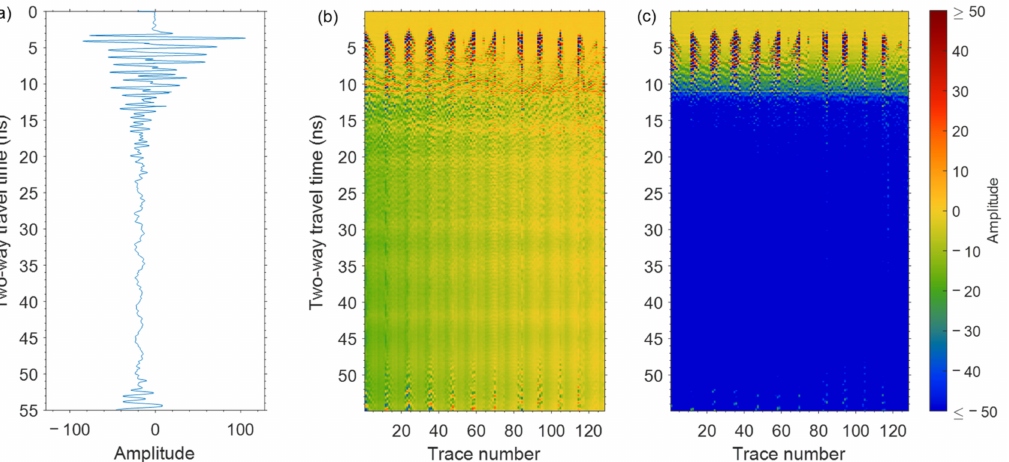
Figure 3. ( a ) Waveform of the first trace of pre-drilling observation data. The reflection from the cable– antenna interface contaminates the signal after 50 ns. ( b ) The radargram of pre-drilling data. ( c ) The radargram of one of the background measurement data. The strongest signals in the radargram are direct waves and ground-reflected